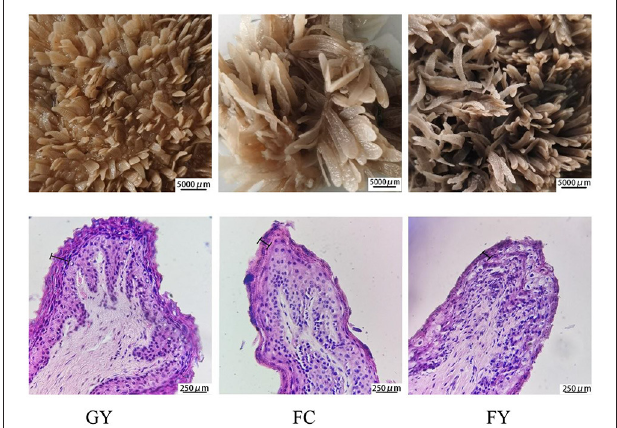
FIGURE 1 | Morphology structure of rumen papillae of grazing yaks (GYs), feedlot-fattened cattle (FC), and feedlot-fattened yaks (FYs) (The 250- µ m scale denotes stratum corneum thickness).